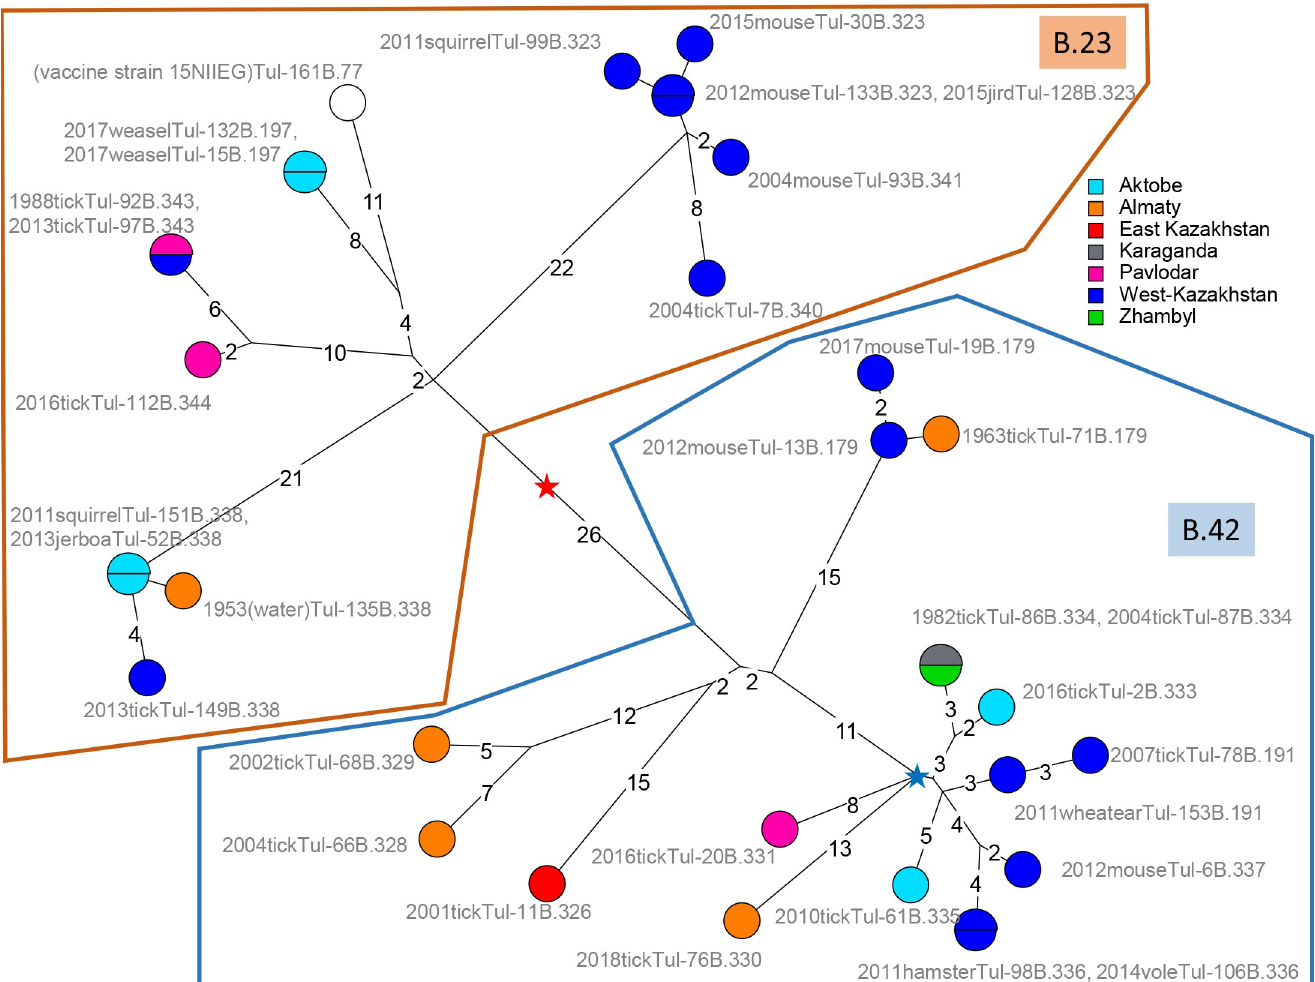
Fig 2. Focus on the 33 Kazakhstan strains belonging to sublineages B.23 and B.42. Two hundred and fifty-four SNPs were called by mapping on reference SCHU_S4 (assembly accession GCA_000008985). The Maximum Parsimony tree size is 254 (no homoplasy). The red star indicates the position of the MRCA. The blue star indicates the root of the B.66 polytomy shown in a larger context in S2 Fig. Strains are labelled with year of isolation, host, strain Id and CanSNP assignment. The color code reflect the geographic origin within Kazakhstan (region level). Branch lengths longer than one are indicated. The branch scale is